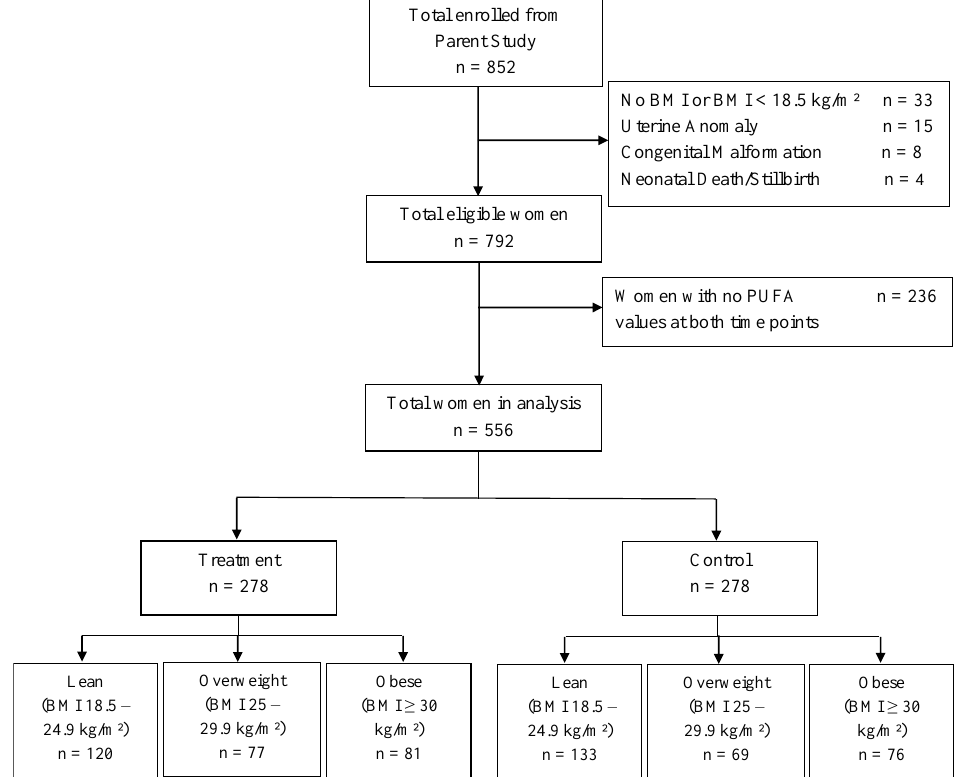
Figure 1. Flow diagram of the included participants. n : number.